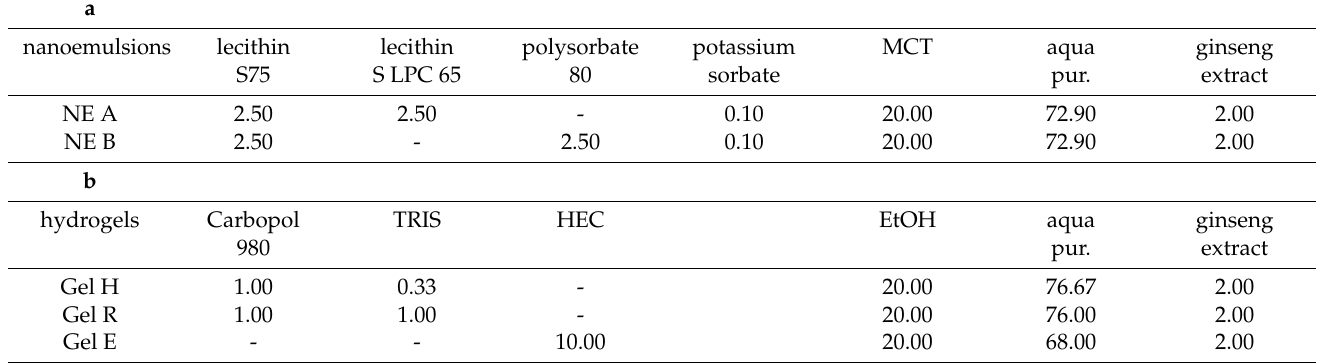
Table 1. Composition in % w / w of the developed (a) nanoemulsions and (b) hydrogels with and without Korean red ginseng dry extract (KRG, incorporated at 2 % w / w ). All formulations were produced in triplicate (n = 3). Abbreviations: aqua pur. = freshly distilled water, EtOH = ethanol